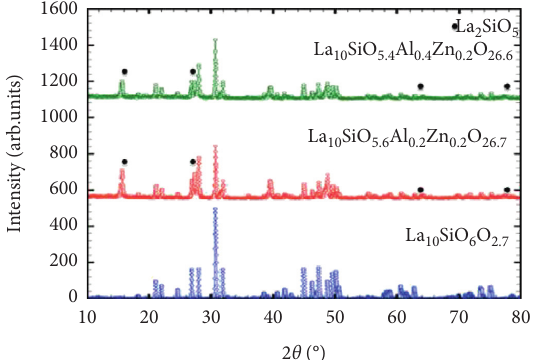
Figure 2: Room temperature XRD patterns of La compared to room temperature XRD pattern of La